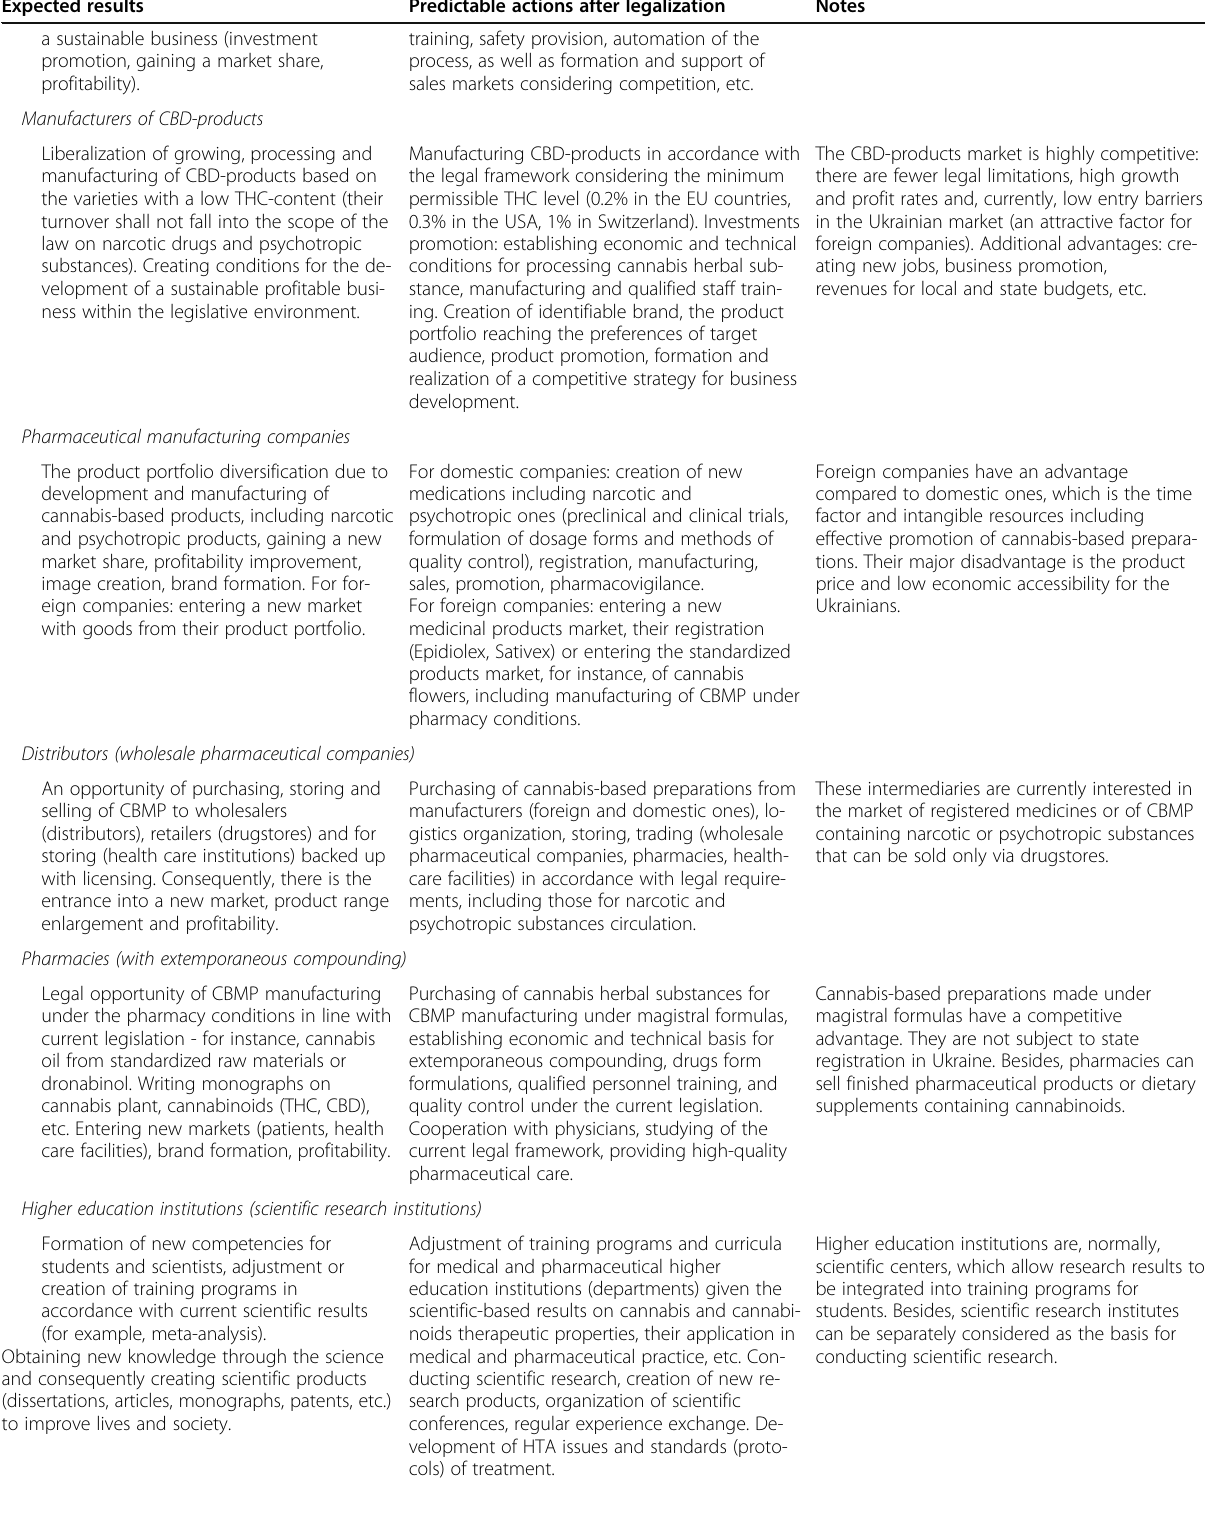
Table 2 Expectations and predictable actions of the key stakeholders in the medical cannabis market in Ukraine